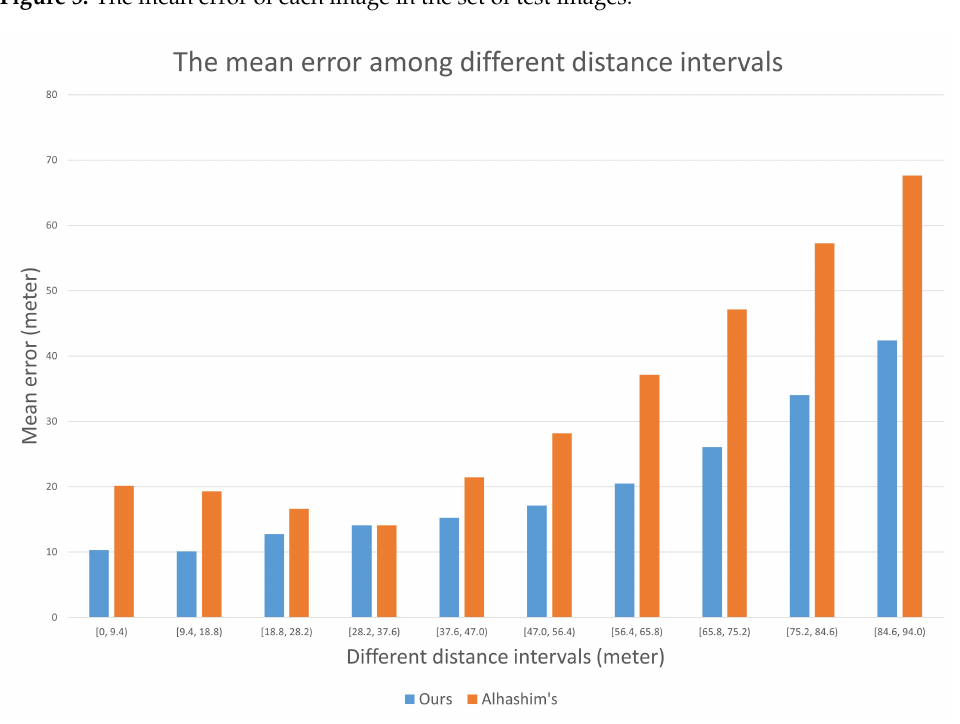
Figure 5. The mean error of each image in the set of test images.